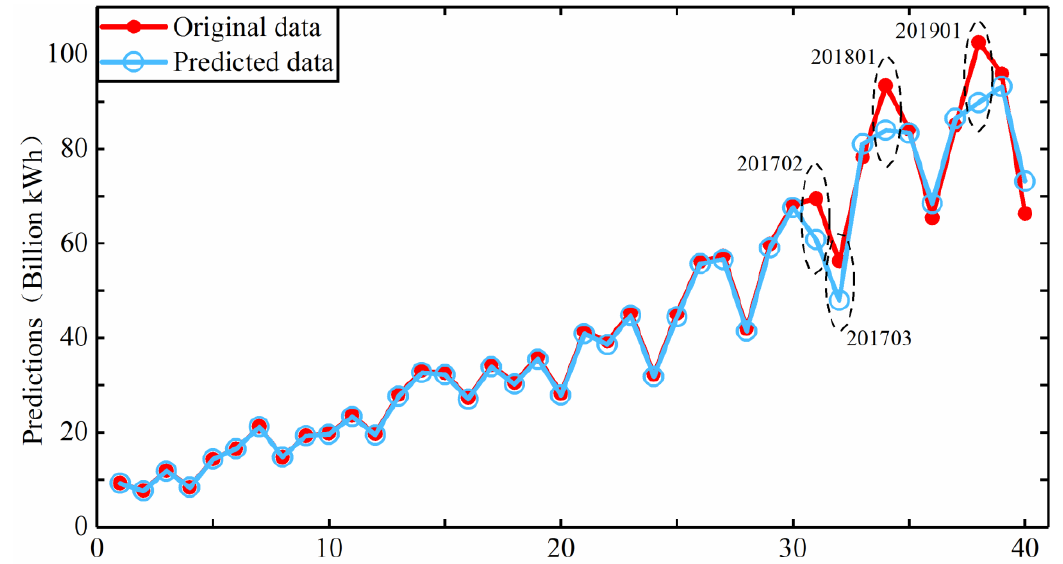
Figure 5. Forecasting results of wind power generation based on WD-LSTM model.